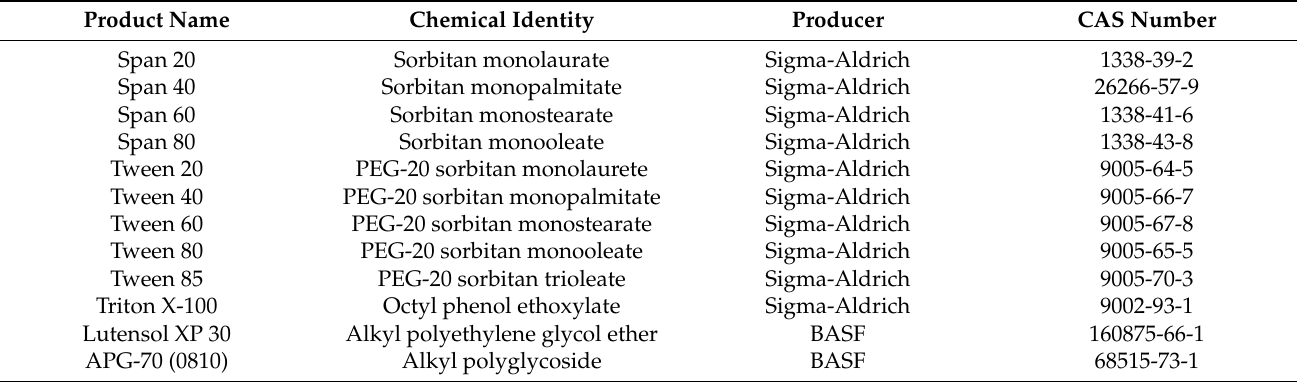
Table 1. The chemical identity of Span and Tween products.